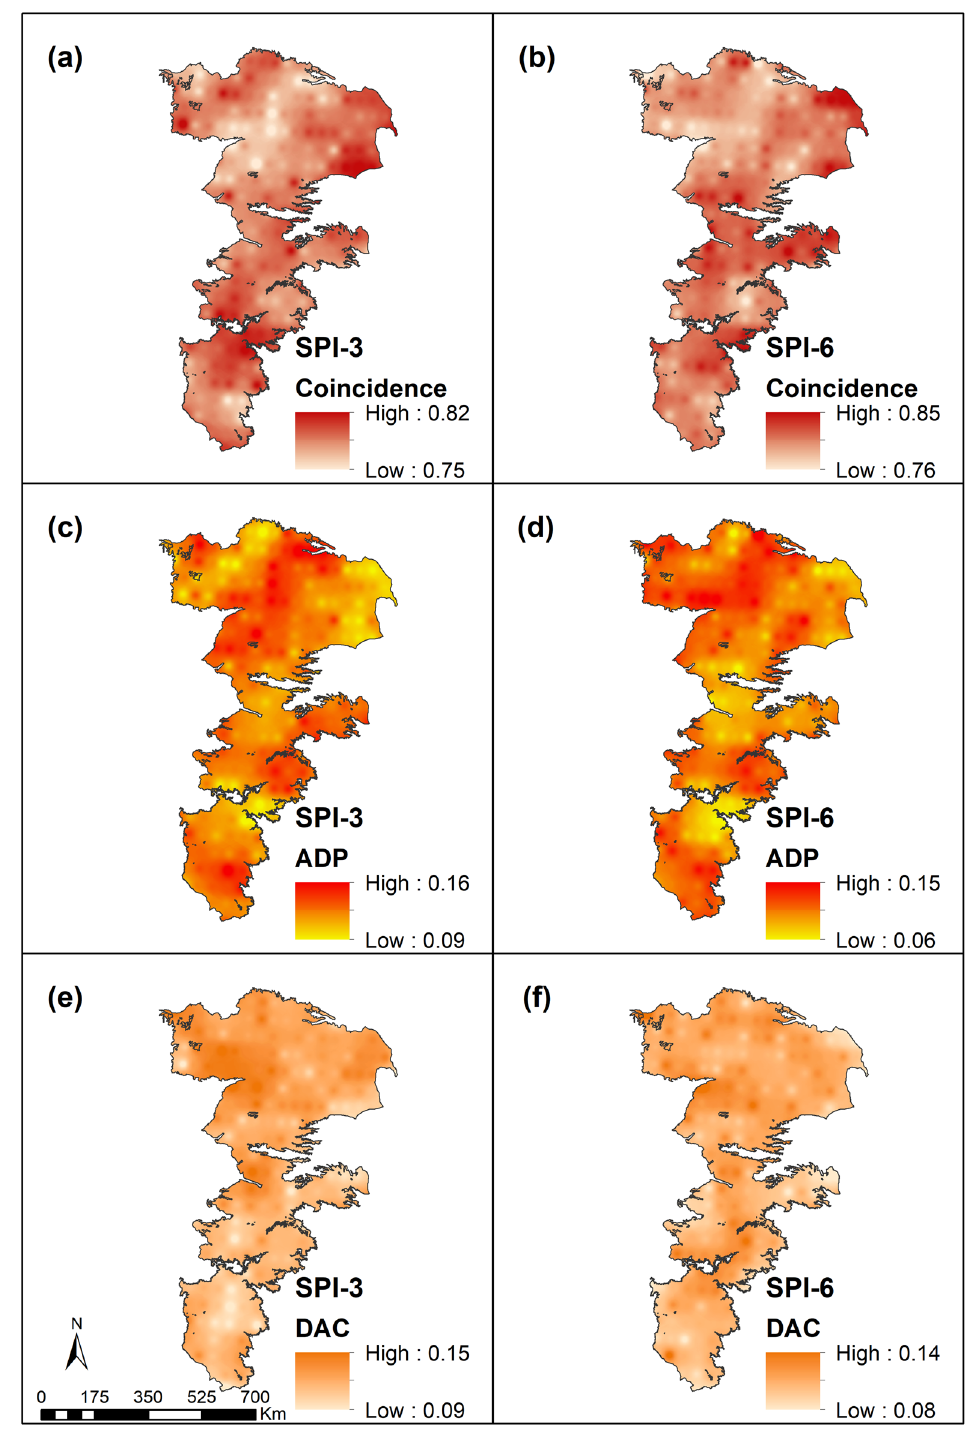
Figure 8. Comparison of meteorological (SPI) and agricultural (SSMI) drought